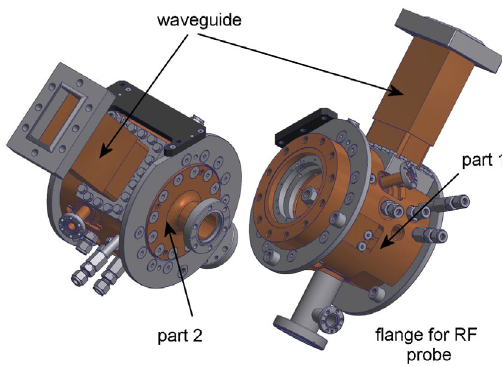
FIG. 5. Mechanical drawing of the gun.